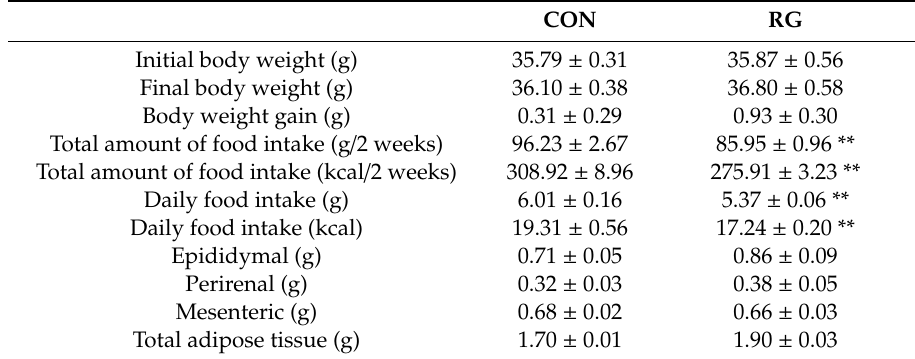
Table 2. Changes in body weight, food intake, and abdominal adipose